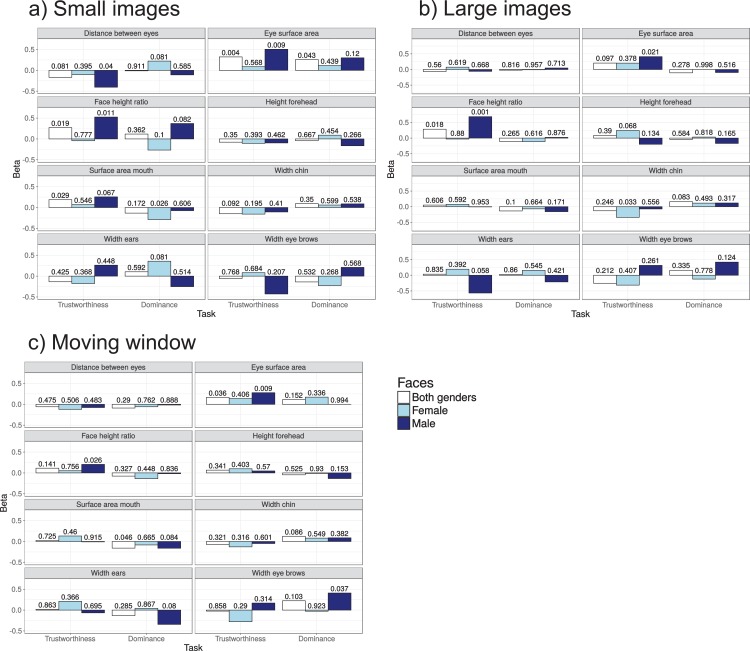
(A–C) Standardized regression weights and associated p-values from a multiple regression model predicting trustworthiness and dominance ratings on the basis of facial features.